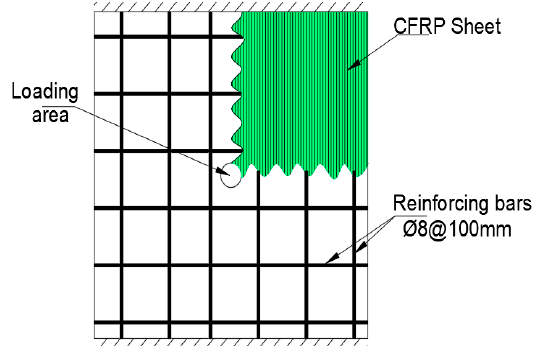
Figure 14. One-way supporting concrete specimen strengthened with CFRP sheet covering the entire specimen except the circular loading area [37].